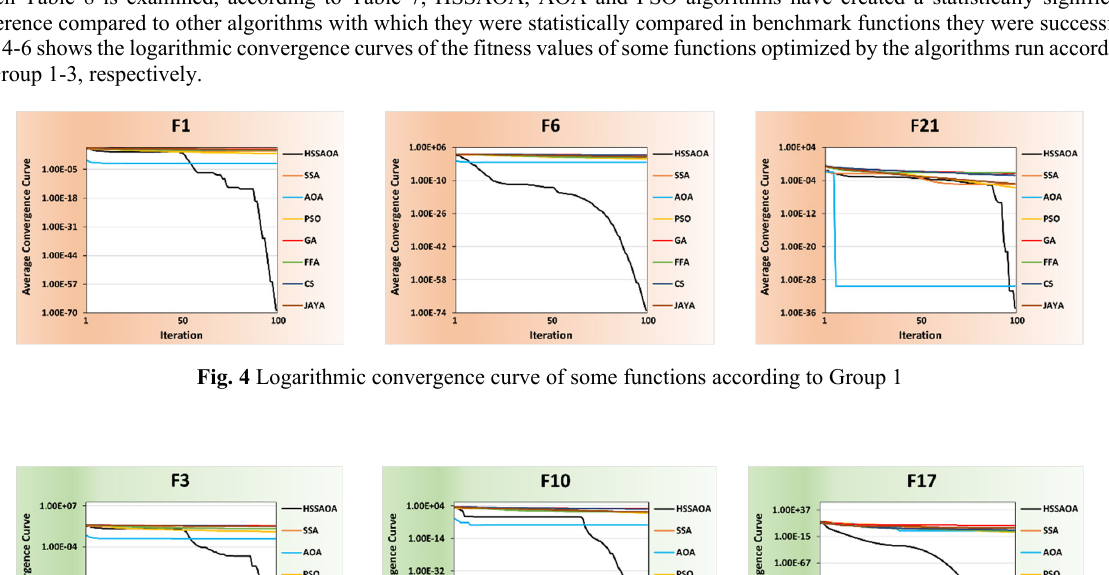
When Table 8 is examined, according to Table 7, HSSAOA, AOA and PSO algorithms have created a statistically significant difference compared to other algorithms with which they were statistically compared in benchmark functions they were successful. Fig. 4-6 shows the logarithmic convergence curves of the fitness values of some functions optimized by the algorithms run according to Group 1-3, respectively.